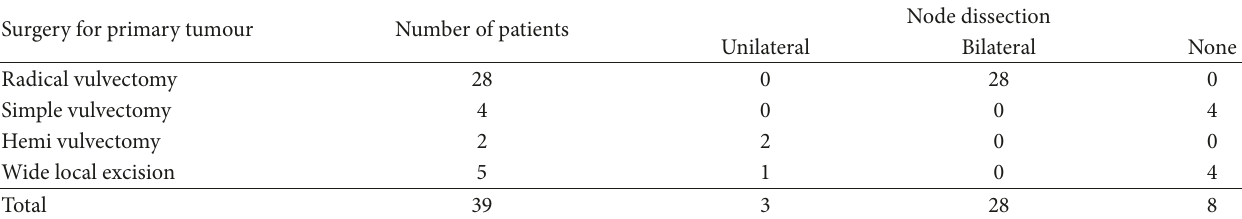
Table 1: Surgical